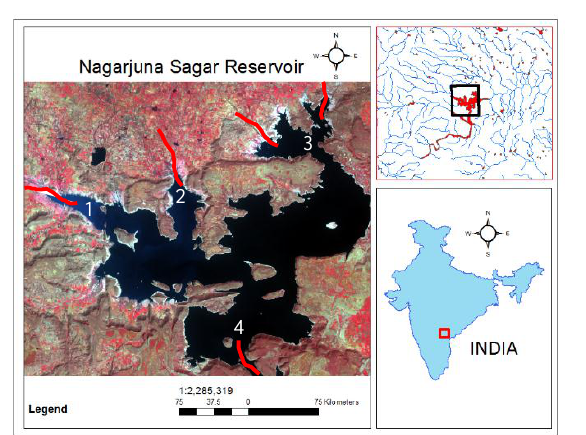
Figure 1. Nagarjuna Sagar reservoir. Points 1,2,3 and 4 are major inlets to this reservoir